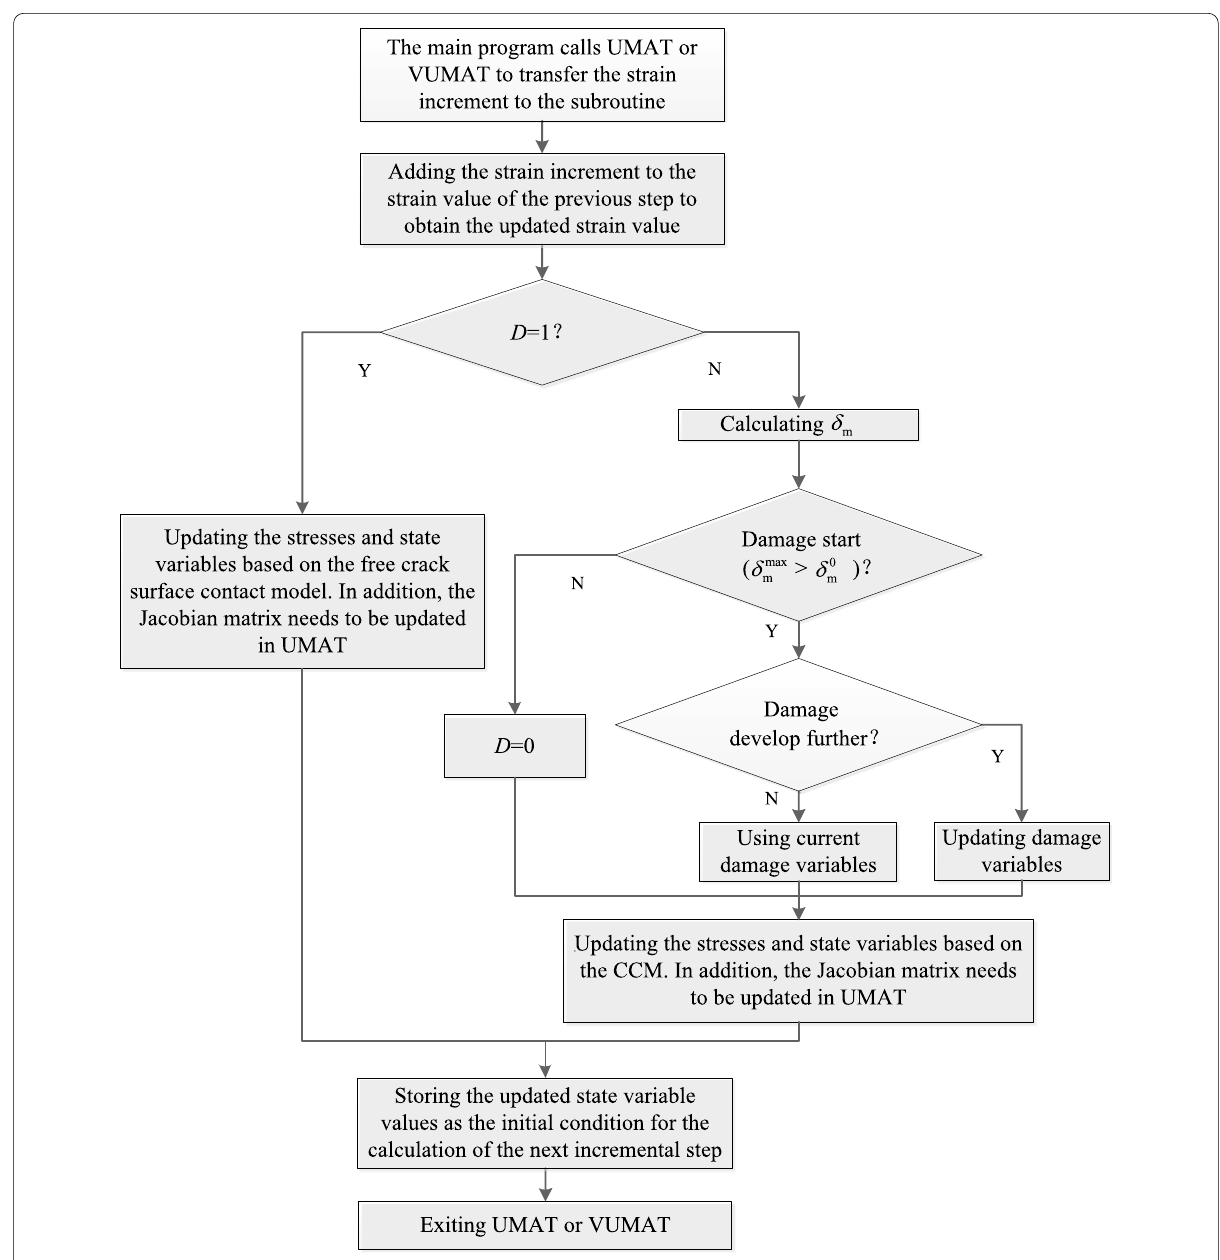
Fig. 3 The calling flow of UMAT or